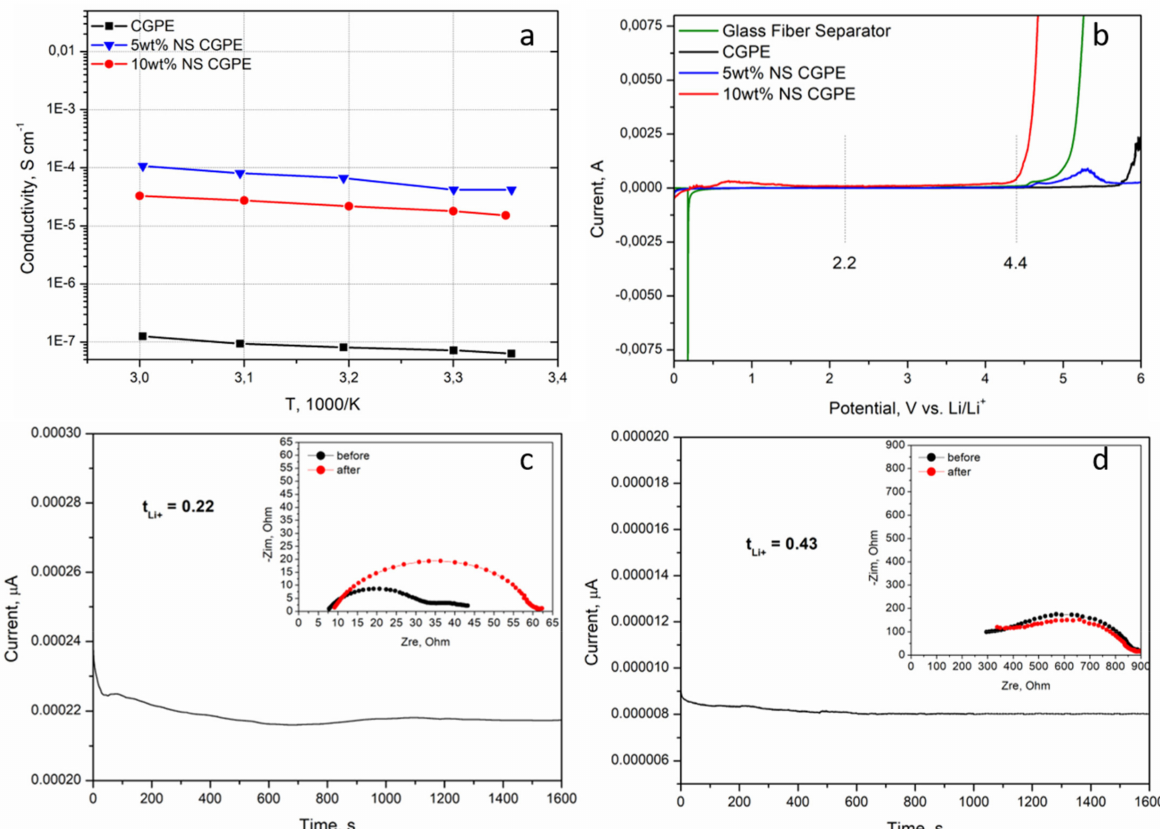
Figure 4. Ionic conductivity vs. temperature plot of the different CGPEs ( a ), LSV profile of the different CGPEs compared to a commercial glass fiber separator impregnated with liquid electrolyte (LiTFSI 0.5 M in DMSO) ( b ). Potentiostatic polarization analysis of a symmetric cell containing the glass fiber separator impregnated with the liquid electrolyte ( c ) and a symmetric cell containing the CGPE with 5 wt% NS ( d